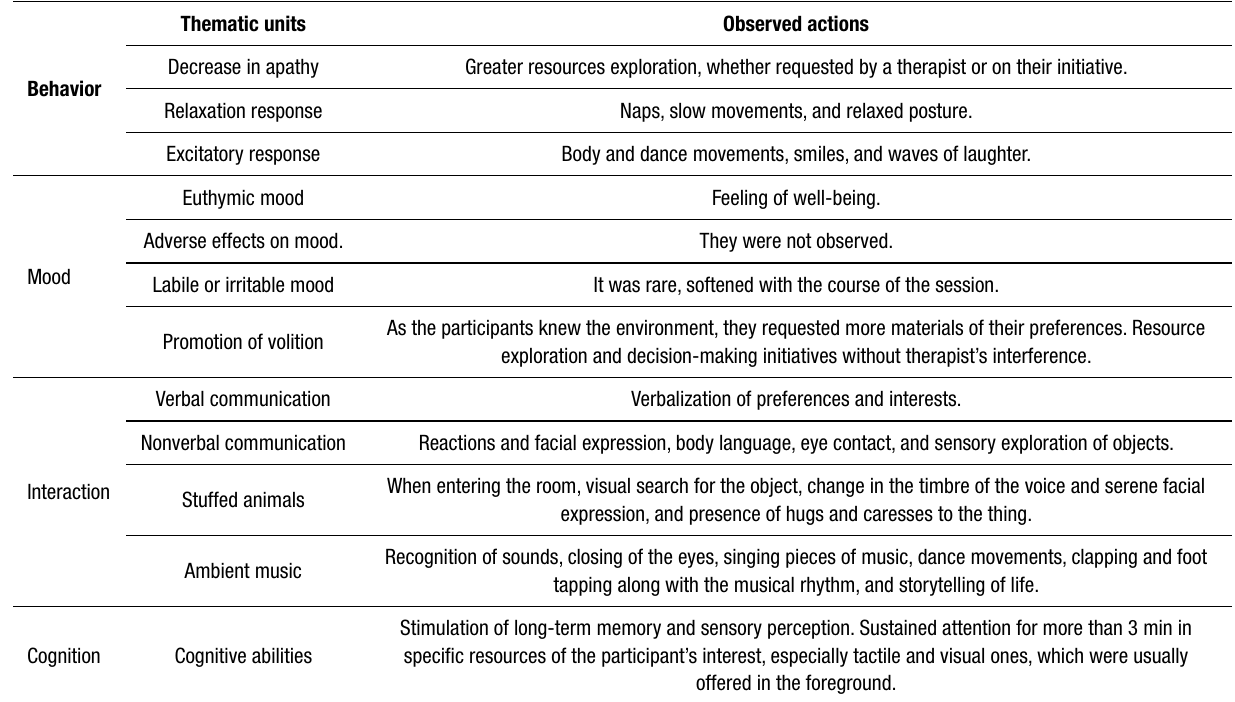
Table 3. Intervention group behaviors, mood, and interaction observed in the multisensory environment.